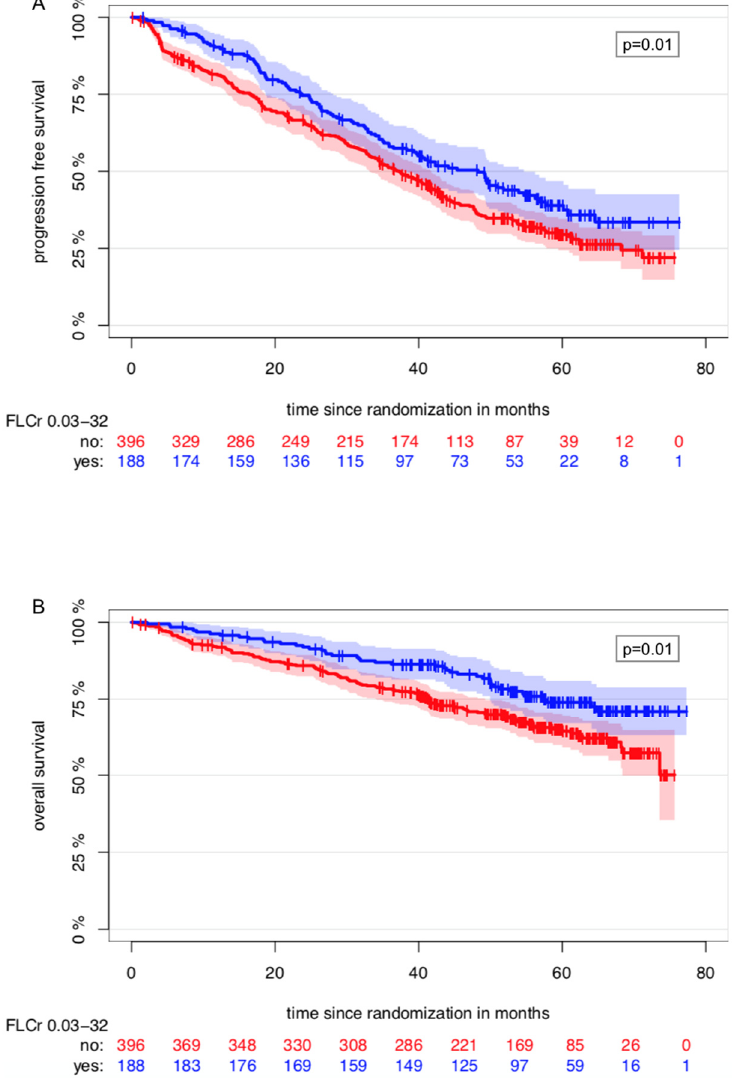
Figure 1. Kaplan–Meier Estimator of the impact of the FLCr at baseline on PFS ( A ) and OS ( B ). 3.2. FLCr Normalization during Therapy in the MM5 Trial and Its Impact on PFS and OS The percentage of patients with a normal FLCr increased from 3.6% (21/590) at base- line to 23.2% (131/564) after induction, 48.5% (249/513) after ASCT and 64.7% (295/456) after consolidation therapy (Figure 2). During maintenance therapy, the percentage slowly decreased from 61.7% (263/426) after three months to 55.4% (209/377) after 12 months to 48.1% (140/291) after 24 months.